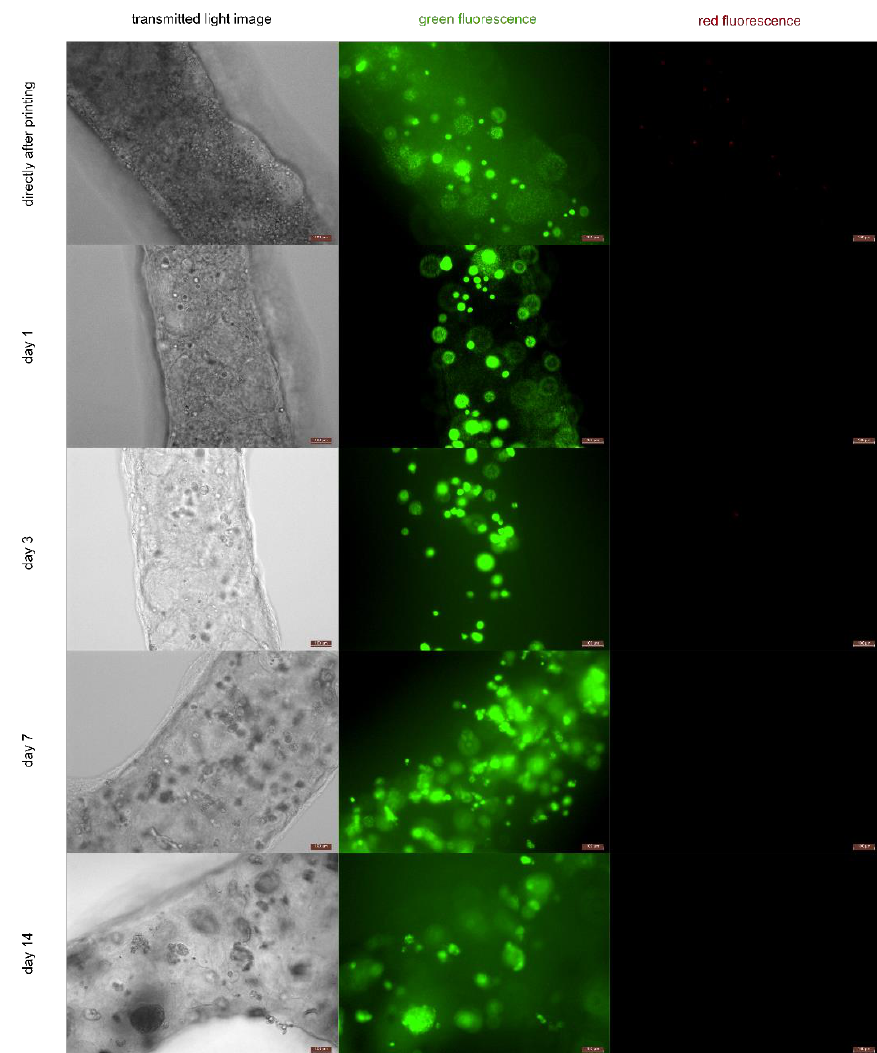
Figure 9. Representative non-processed images of a cell-laden strand over time. Left panels show transmitted light images. Center panels show the green fluorescence channel (FDA), indicating the viable cells. Right panels show the red fluorescence channel, indicating dead cells (PI). Scale bar = 100 µm. For high quality images, the reader is referred to the web version.